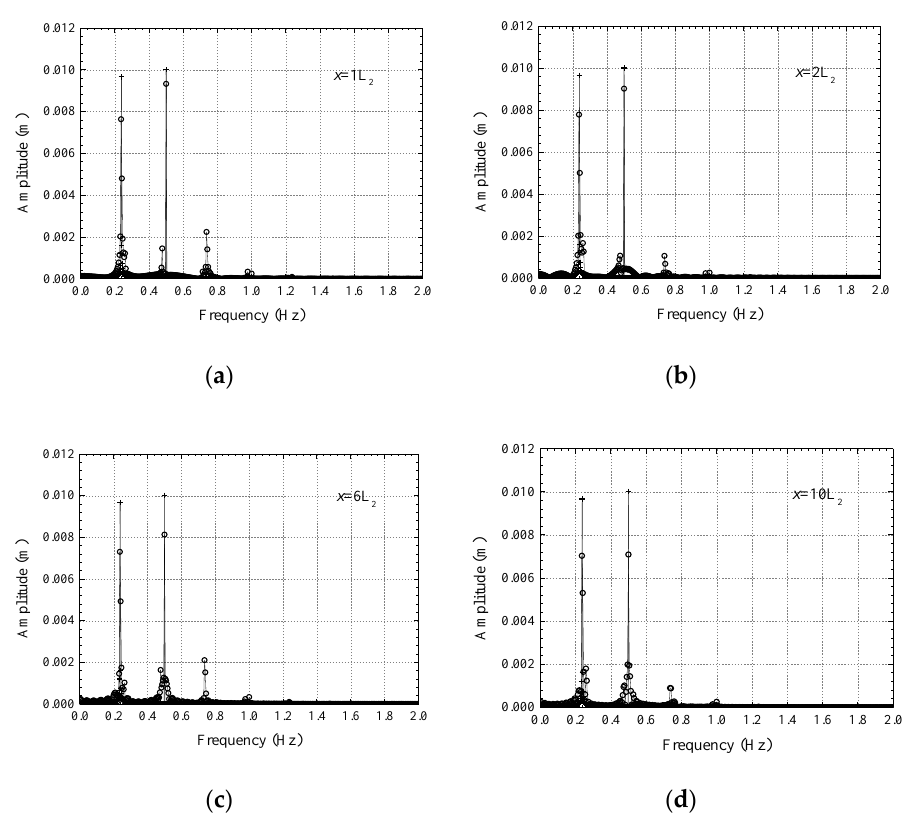
Figure 6. Frequency domain plots of wave simulation results at X = 1L 2 ( a ), X = 2L 2 ( b ), X = 6L 2 ( c ), X = 10L 2 ( d ) of the MIKE 21 BW model ( ○ ) and the theoretical solution ( ┼ ) (operating condition C2).